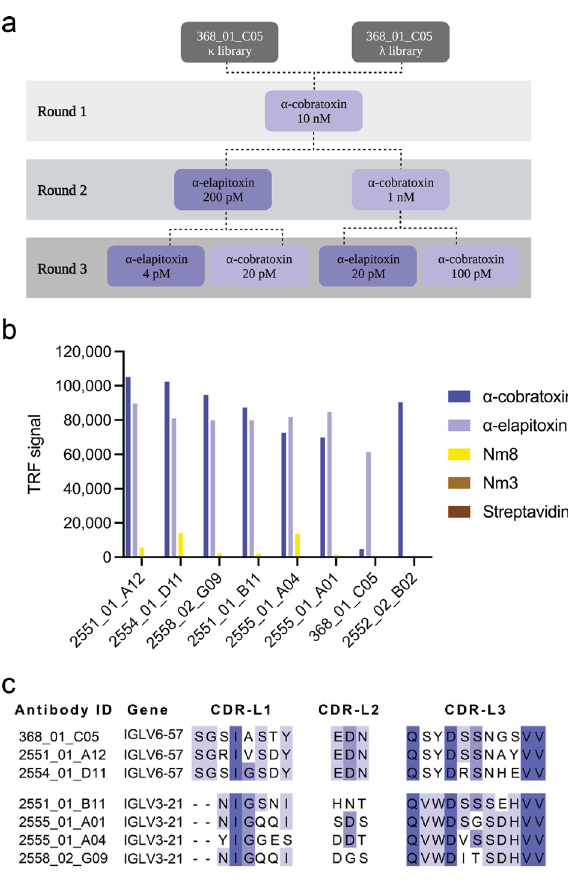
Fig. 1 | Cross-panning selectionstrategy aswellas assay and sequence data for selected IgGs. a Selection strategy illustrating how cross-panning was performed, includingantigenconcentrations. b ENCDELFIAshowingcross-reactivityofthetop six-af fi nity matured IgGs (2551_01_A12, 2554_01_D11, 2558_02_G09, 2551_01_B11, 2555_01_A04, and 2555_01_A01) in comparison with parental IgG (368_01_C05) and clone 2552_02_B02 from a previously published study 15 . c Comparison of CDR-L1, CDR-L2, and CDR-L3 sequences for the top six chain-shuf fl ed antibodies and the parental